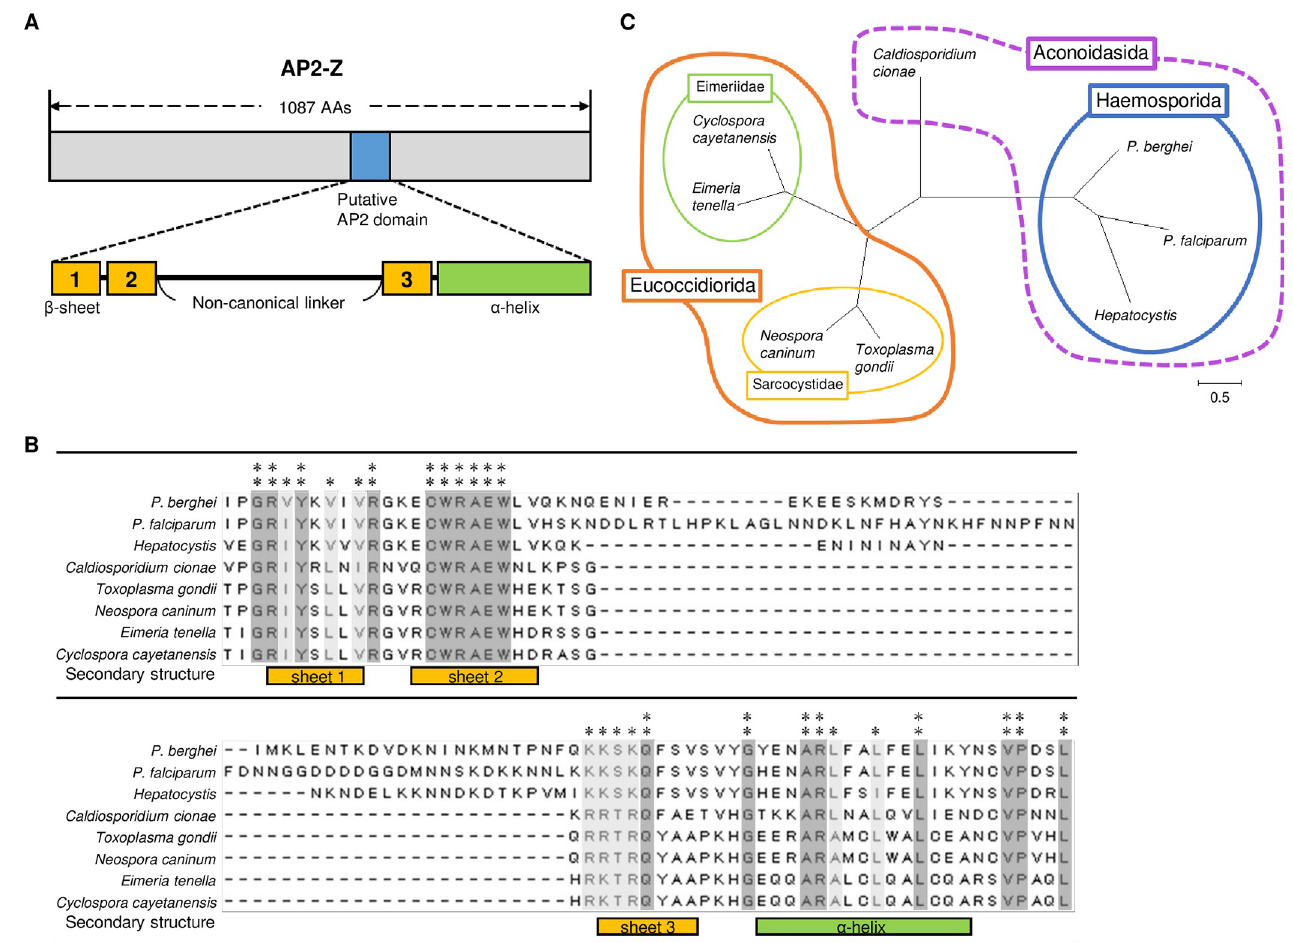
Fig 1. Identification of possible AP2-Z orthologs in Apicomplexan parasites. (A) A schematic illustration of AP2-Z. Blue box shows the AP2 domain. Beta- sheet and α -helix regions in the AP2 domain were predicted using PSIPRED (http://bioinf.cs.ucl.ac.uk/psipred/) and indicated in orange and green boxes, respectively. (B) Alignment of conserved amino acid sequences from AP2-Z and blastp-searched proteins by the ClustalW program in Mega X. Positions at which all sequences have an identical amino acid are indicated by two asterisks, whereas positions with amino acid residues of the same property are indicated by one asterisk. Amino acid sequences were retrieved from PlasmoDB or the NCBI database ( P . berghei , PBANKA_0612400; P . falciparum , PF3D7_0411000;